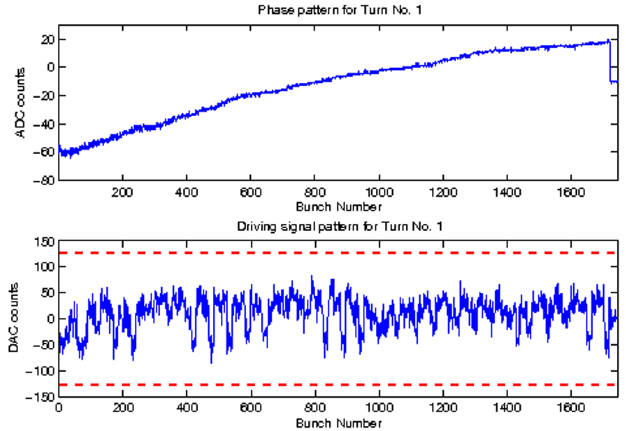
FIG. 16. (Color) Time-domain fault file (same data as Figs. 8 and 9) processed to show the data of the input bunch motion transformed to the modal domain. Once HOM control is lost for a few bunches from power stage saturation, the runaway HOMs in the band centered at mode 800 grow exponentially. Mode 800 is the largest impedance in the cavity HOMs.